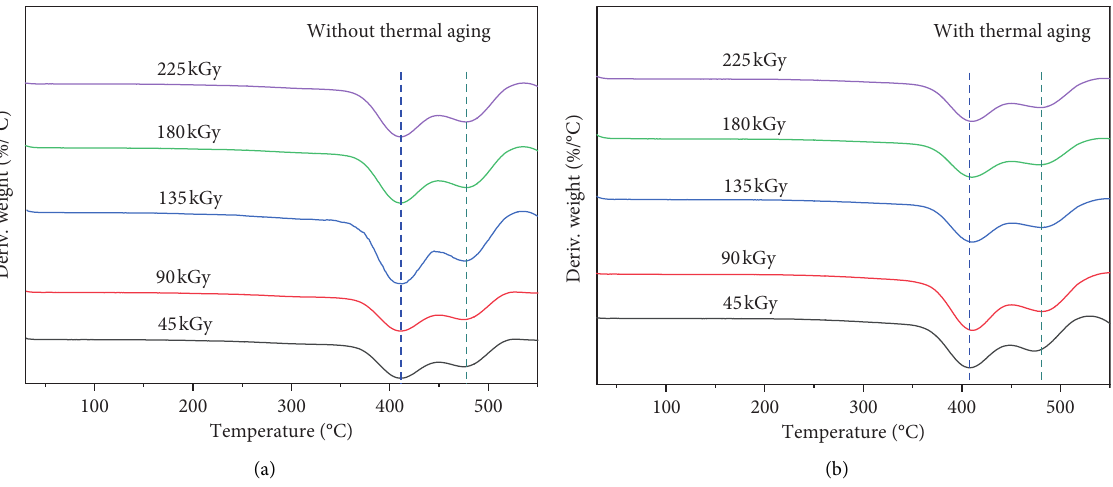
Figure 6: TDG curves of BR/NR blends at different doses, nonaging and aging.